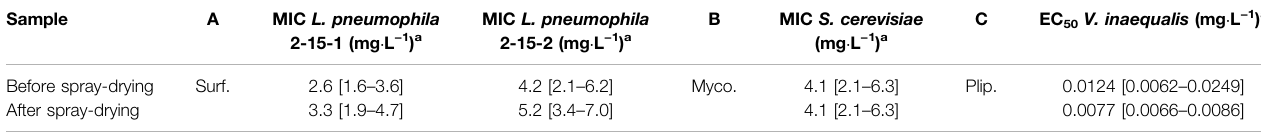
TABLE 2 | Determination of the lipopeptide activities before and after the spray-drying process: anti- Legionella activity for surfactin samples (A) , antifungal activity against Saccharomyces cerevisiae for mycosubtilin samples (B) , and antifungal activity against Venturia inaequalis for plipastatin samples (C) .